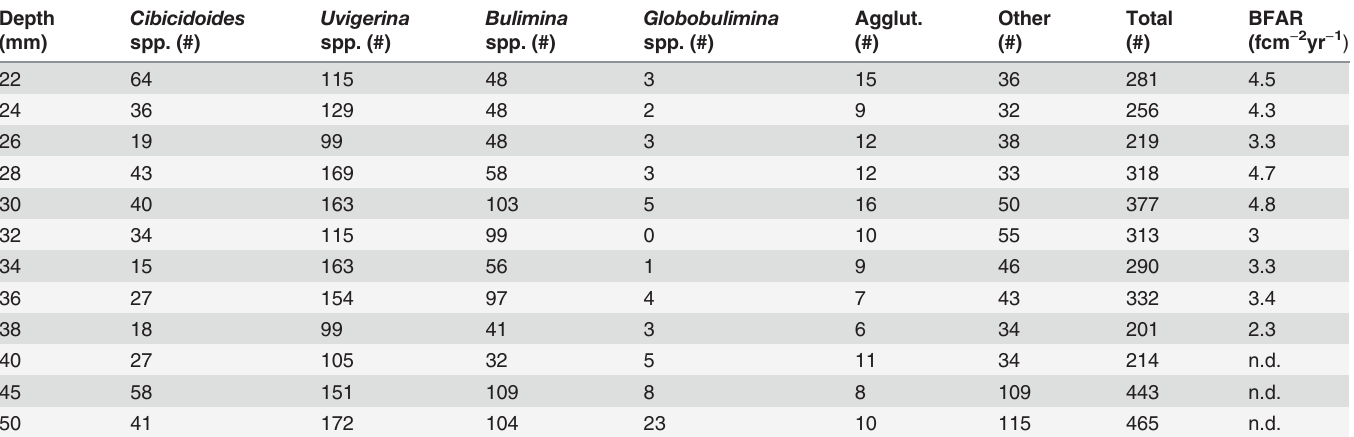
described in Denne and Sen Gupta [24] with the exception of an increase in Bolivina spp. While agglutinated genera were present in every sample at each site, they were certainly not the dominant genera at either of the sampling sites. This disagreement with Bernhard et al. [27] might have been due to the loss of some agglutinated foraminifera in the freeze-drying and wet sieving methods. There were not enough benthic foraminifera in the 10 – 12 mm (DWH event, 2010 CE) section of the February 2011 DSH08 record to compare with previous studies. The down-core (15 – 40 mm) PCB06 intervals (pre-DWH) shared two of the dominant species ( Bolivina spp. and Uvigerina spp.) with the hydrocarbon seep communities presented in Sen Gupta and Aharon [25]. However, these records differed with respect to the dominance of Buli- mina spp. in PCB06 and lack of Bulimina spp. in most of their hydrocarbon seep sites (F1, F12, F15). There were not enough benthic foraminifera, epifaunal or infaunal, in the surface (post- DWH) of the PCB06 cores to compare dominant genera with previous records.